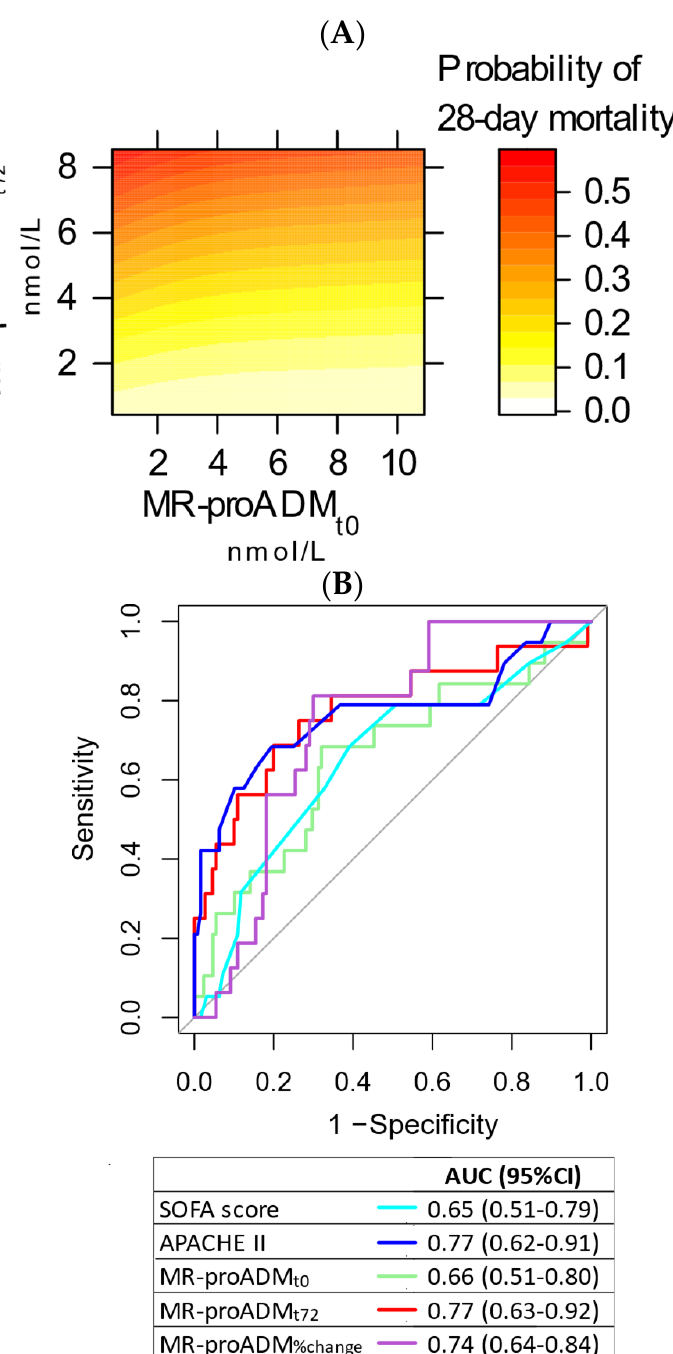
Figure 2. Contour plot showing the interaction of proADM t0 and proADM t72 in the prediction of 28-day mortality (panel ( A )). ROC curve analysis for 28-day mortality (panel ( B )). Kaplan–Meier survival curves were computed for MR-proADM t0 (cut-off 2.78 nmol/L), MR-proADM t72 (cut-off 2.7 nmol/L) and MR-proADM %change (cut-off − 15.2%). All were able to differentiate prognosis with a statistically significant log-rank test ( p = 0.003, p < 0.001 and p < 0.001, respectively, Figure